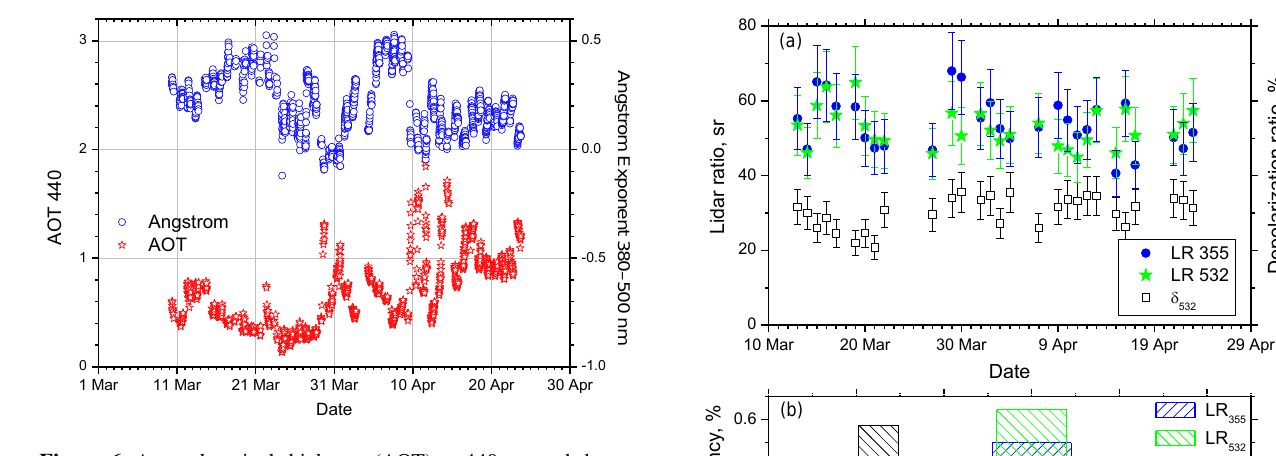
tios for both wavelengths are similar: LR 355 = 54 ± 8 sr and LR 532 = 53 ± 8 sr. The mean value of the particle depolariza- tion ratio is 30 ± 4.5 %; however, during the dust events the depolarization ratio could increase up to 35 ± 5